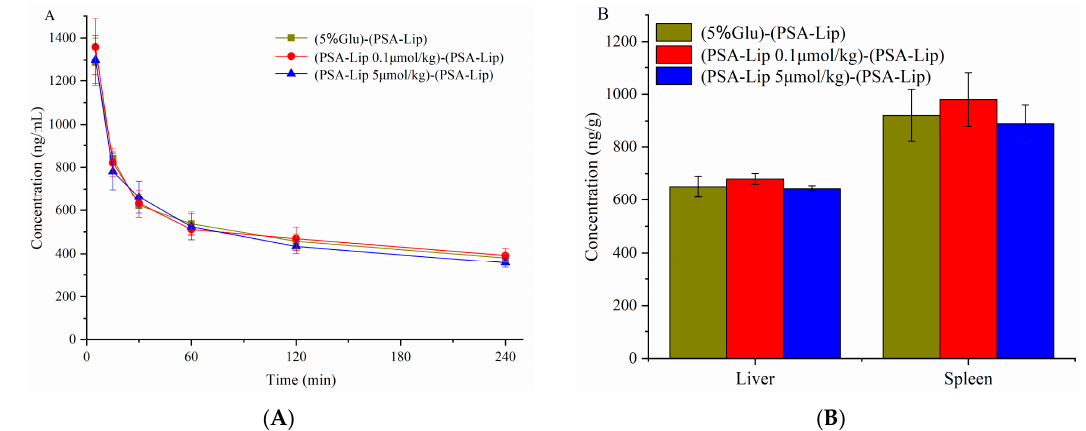
Figure 4. ( A ) Pharmacokinetic profile in wistar rats after the repeated injection of PSA-Lip (0–4 h). ( B ) Hepatic and splenic accumulation (4 h) in rats after second injection of PSA-Lip. Data were shown as mean ± S.D., n = 3.